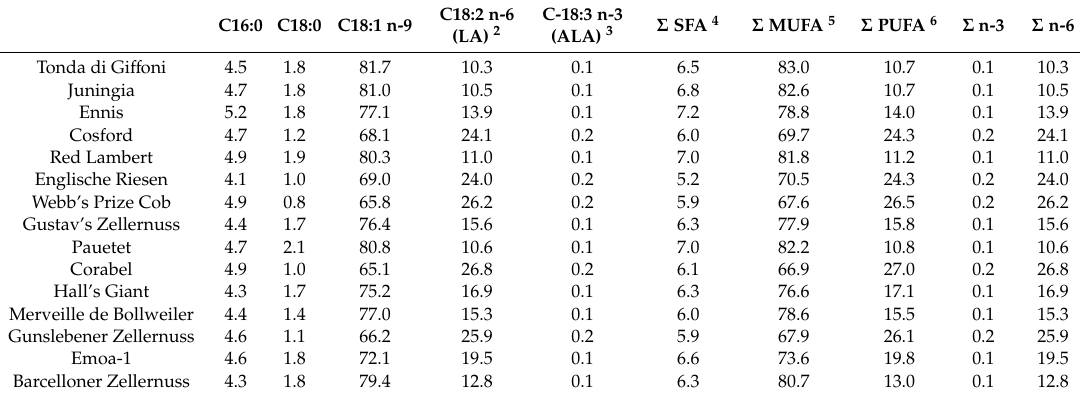
Table 2. Fatty acid composition (% of total FAME 1 ) of 15 hazelnut cultivars grown under identical conditions in Thuringia,